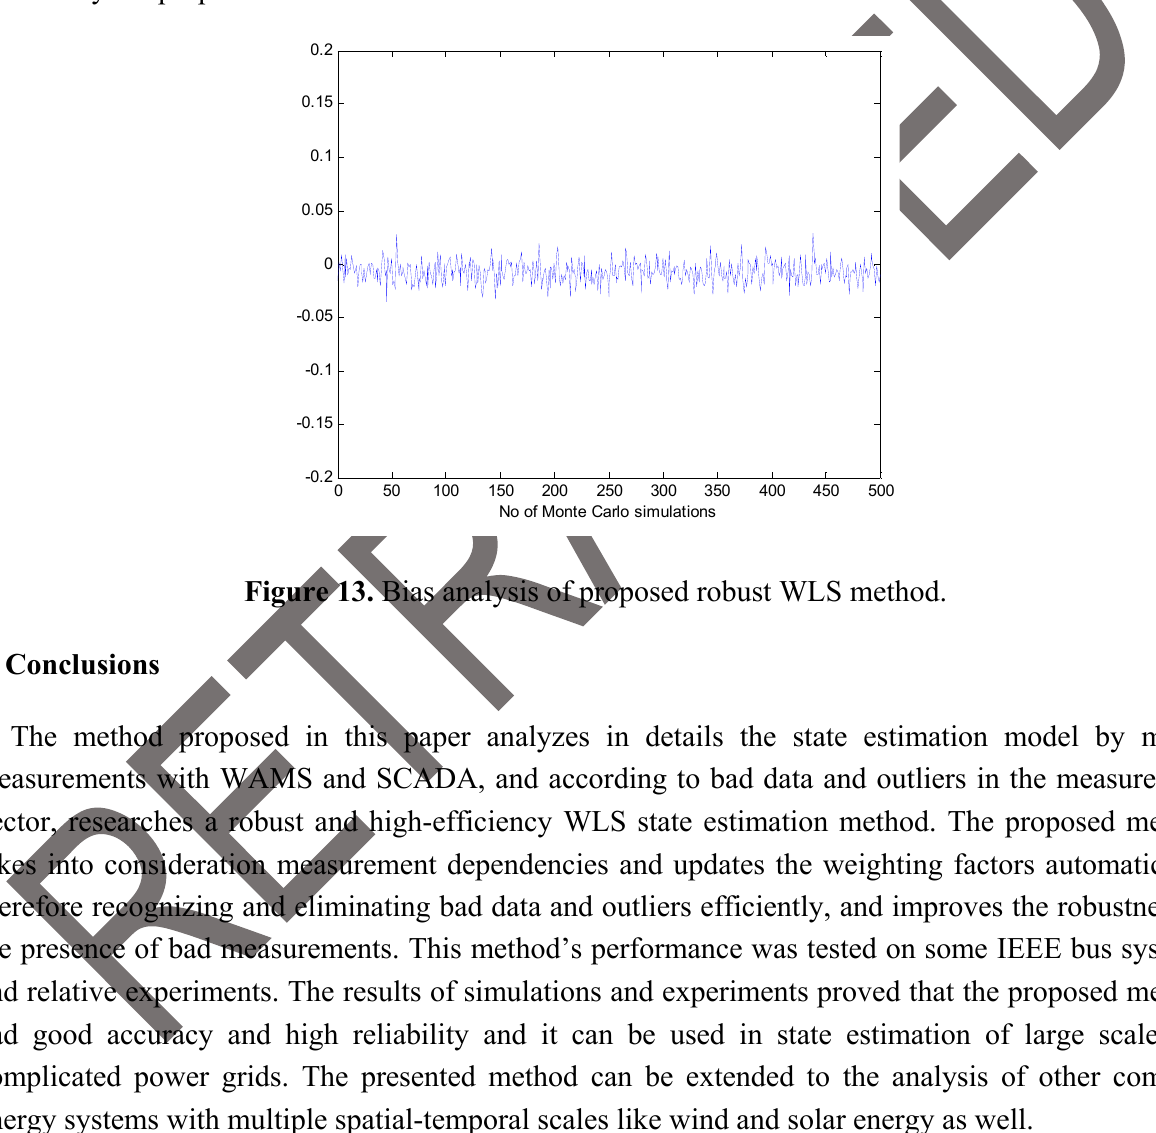
Figure 13. Bias analysis of proposed robust WLS